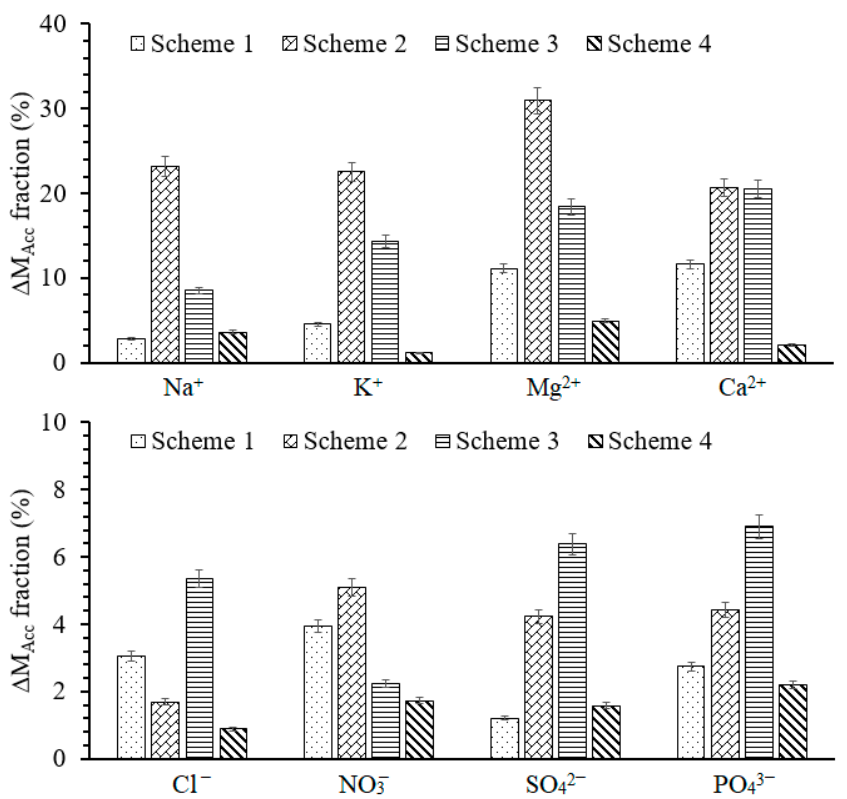
Figure 4. The accumulated mass fraction of cations and anions. The error bars represent the standard deviation of last three sampled days of all operational deviation of last three sampled days of all operational schemes.